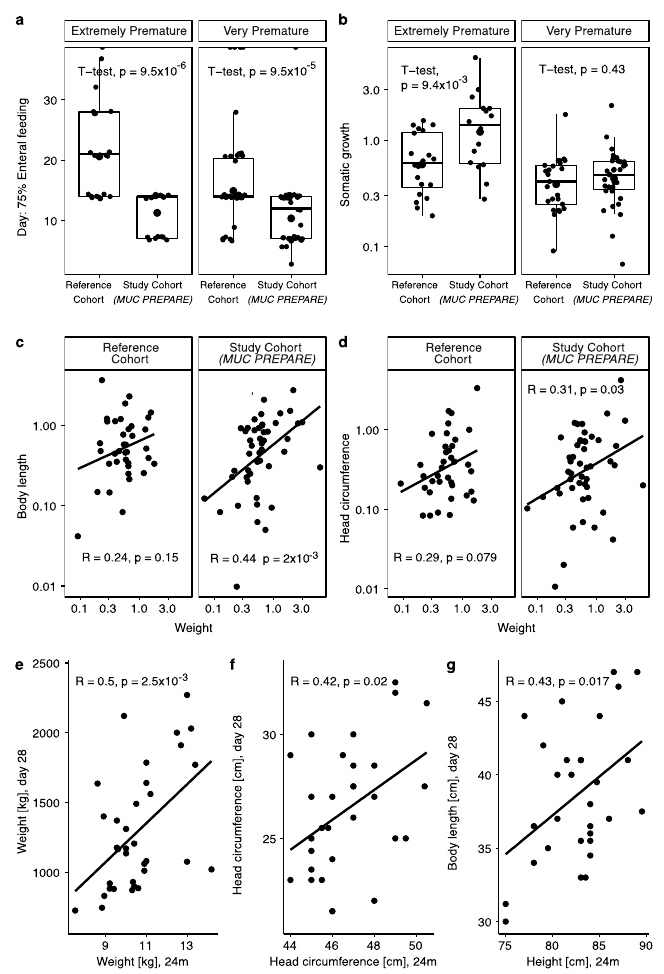
Figure 4. ( a ) Days of life by when infants achieved 75% enteral feeding in percentage of total volume (mL) given separated by immaturity. ( b ) Somatic growth calculated as change in percentiles at day of birth and day 28 of life separated by immaturity. ( c , d ) Scatterplots showing Pearson correlations of weight with ( c ) body length and ( d ) head circumference separated by cohort. ( e – g ) Scatterplots showing Pearson correlations over both cohorts in available data showing that the ( e ) body weight (kg), ( i ) head circumference (cm), and ( g ) height/body length (cm) correlate with the respective val- ues at 24 months. Extremely immature: <27 GA weeks, very premature: 27 – 32 GA weeks. Study cohort ( MUC PREPARE ): 2012 – 2014, reference cohort: 2007 – 2009.